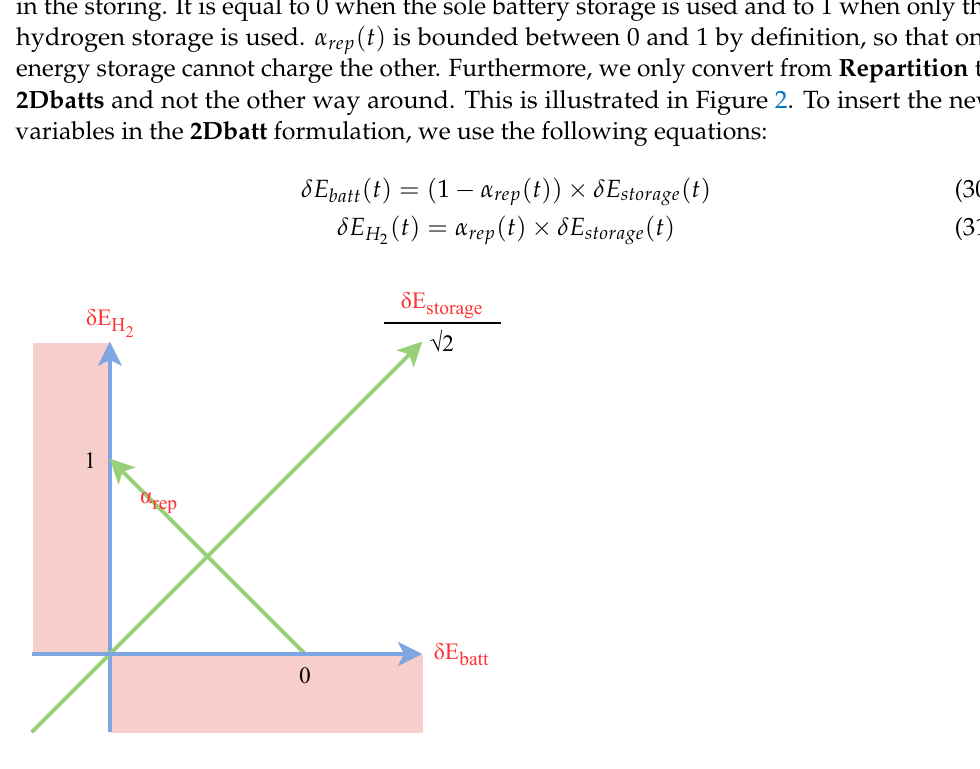
Figure 2. Repartition formulation (green), δ E storage ( t ) and α rep ( t ) , in the 2Dbatt (blue) action space. Actions where one storage is charged and the other discharged are highlighted in